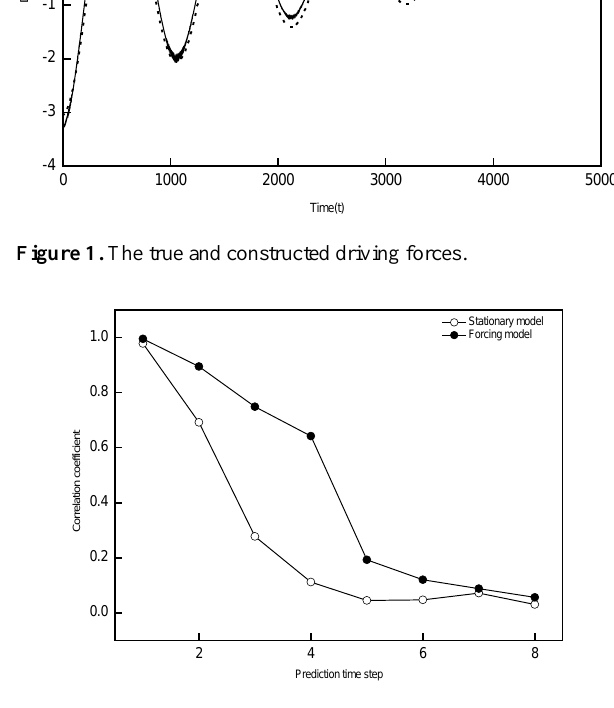
Figure 2. The comparison of prediction skills between models com- bined with or without driving force.